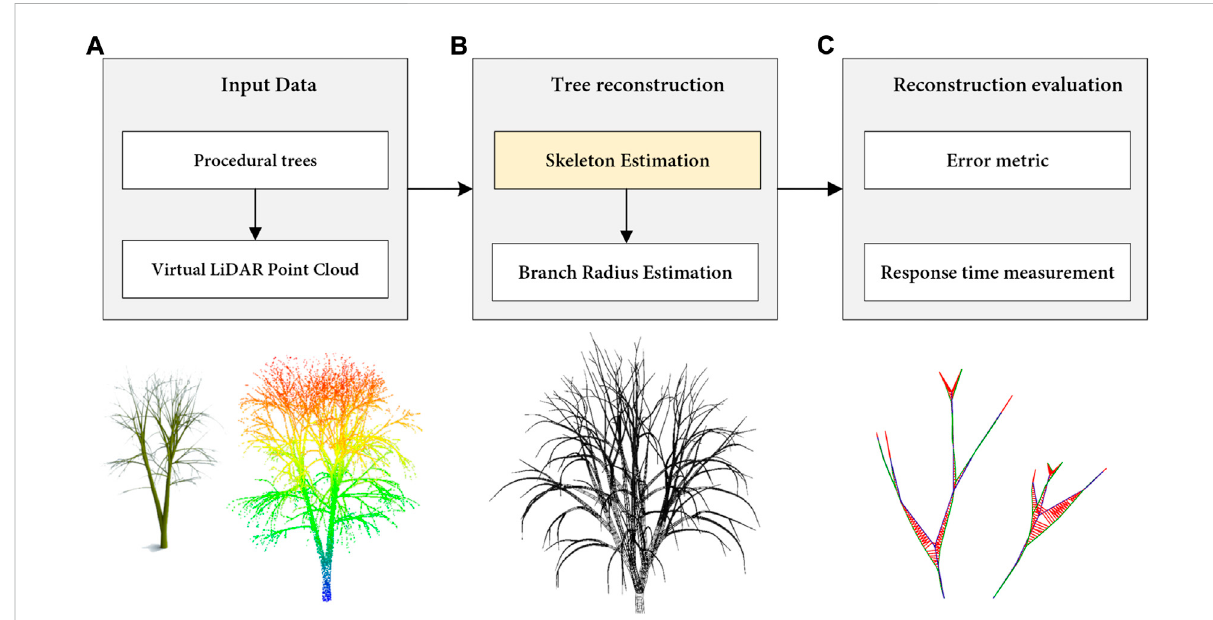
FIGURE 1 Overview of the proposed method for the reconstruction of tree branching structures. (A) First, a set of tree species is procedurally generated using a virtual LiDAR scanner. (B) Next, the skeleton is modeled by branch extraction. (C) Finally, the quality of the output skeletons and the performance of the method on real LiDAR models are